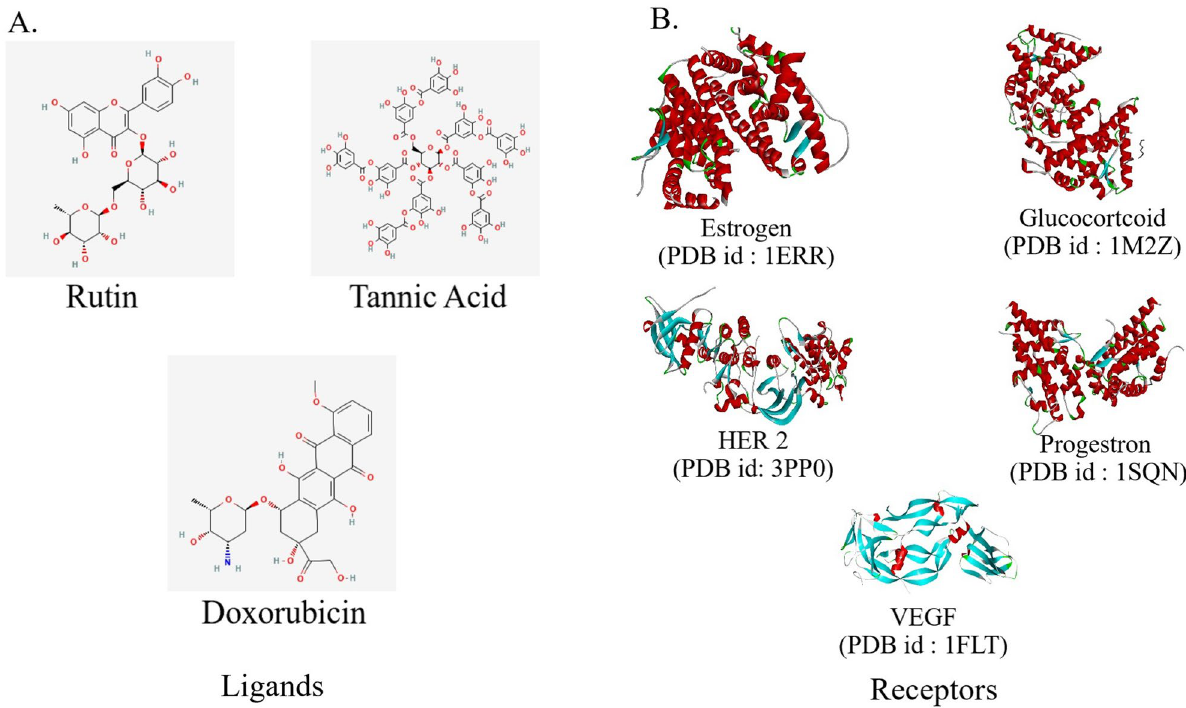
Figure 7. ( A ) Rutin, Tannic acid and Doxorubicin as ligands for molecular docking with ( B ) receptors of cervical cancer i.e., Estrogen (PDB ID: 1ERR), Glucocorticoid (PDB ID:1M2Z), HER 2 (PDB ID: 3PP0), Progesterone (PDB ID: 1SQN) and VEGF (PDB ID:1FLT).